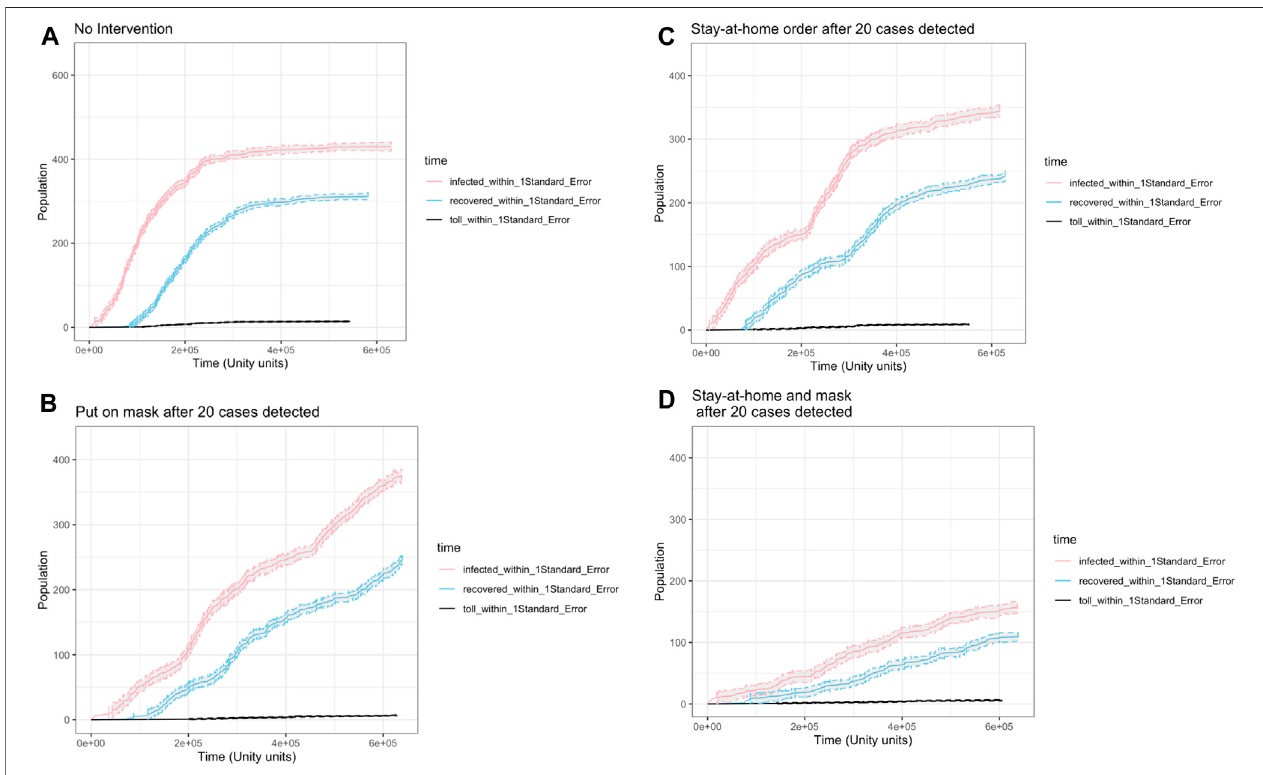
FIGURE 2 | The results of different public health intervention methods on infection rate over time: (A) no intervention (B) “ put on mask ” intervention after fi rst 20 cases detected (C) “ stay at home ” intervention after fi rst 20 cases detected and (D) “ stay at home ” and “ put on mask ” in effect after fi rst 20 cases detected.